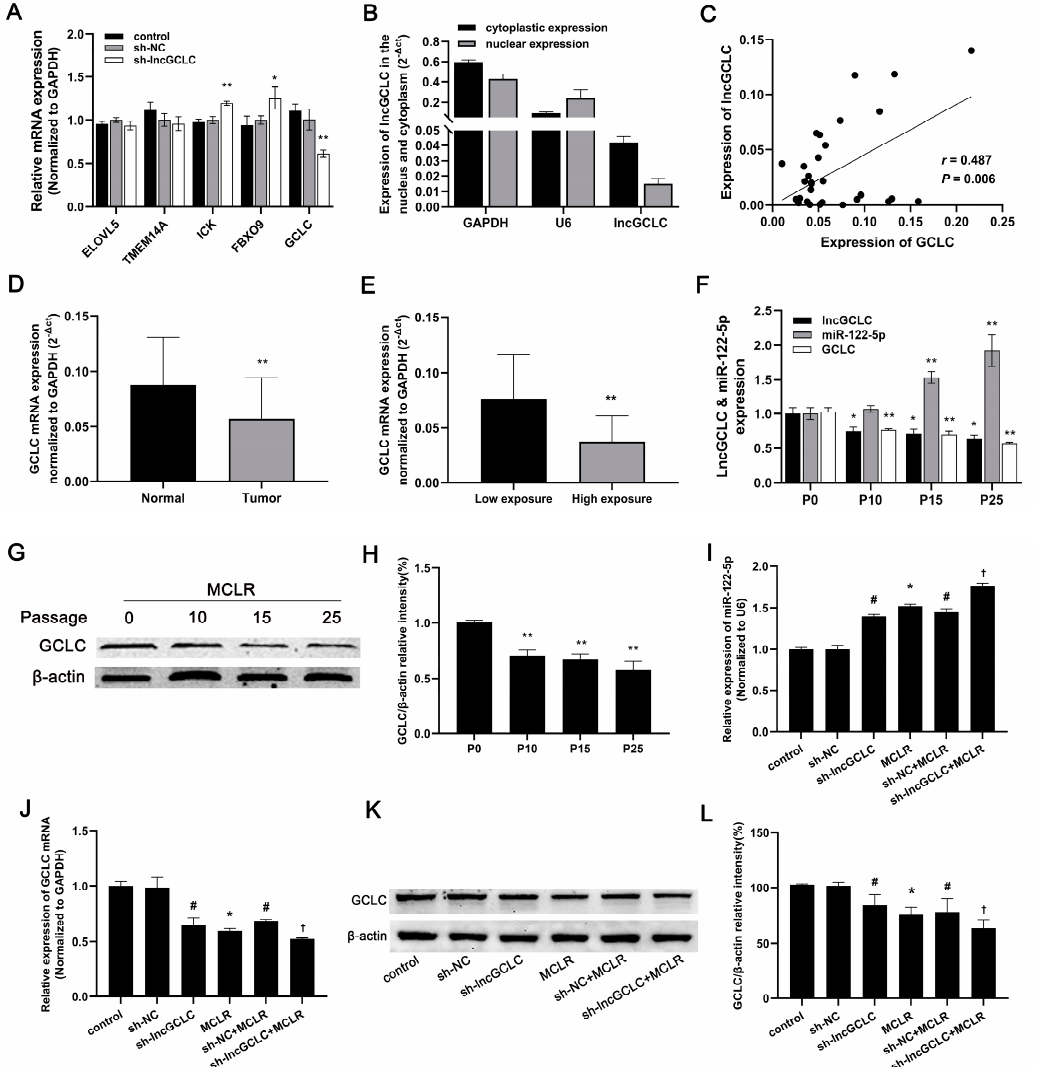
Figure 5. Verification of the interrelationships among lncGCLC, miR-122-5p, and GCLC. ( A ) The mRNA expression level of neighboring genes which are located nearly 1.5 Mb downstream of lncGCLC in lncGCLC knockdown cells. * p < 0.05 and ** p < 0.01 compared with vector control cells. ( B ) The expression level of lncGCLC in the nuclear and cytoplasmic fractions of WRL68 cells. ( C ) The correlation between the lncGCLC expression and the GCLC expression in HCC tissues (n = 30). Correlation coefficient ( r ) and P value were calculated by Pearson correlation analysis. ( D ) Comparison of GCLC expression in tumor tissue and adjacent normal tissue from HCC patients with MC exposure (n = 30), ** p < 0.01. ( E ) GCLC expression in HCC patients with high MC exposure (serum MCs ≥ 0.14 μ g/L, n =17) was lower than in those with low MC exposure (serum MCs < 0.14 μ g/L, n = 13), ** p < 0.01. ( F ) After exposure to 10 μ g/L of MCLR for 0, 10, 15, and 25 passages, expression of lncGCLC, miR-122-5p and GCLC mRNA was detected in WRL68 cells. * p < 0.05 and ** p < 0.01 compared with passage-matched control cells. ( G , H ) Expression of GCLC protein in P0, P10, P15 and P25 MCLR-induced malignantly transformed WRL68 cells. ** p < 0.01 compared with passage-matched control cells. ( I ) Changes of miR-122-5p in both vector- and sh-lncGCLC-transfected WRL68 cells treated with 0 or 10 μ g/L of MCLR for 25 passages. ( J – L ) Changes of GCLC mRNA ( J ) and protein ( K , L ) expression in both vector- and sh-lncGCLC-transfected WRL68 cells treated with or without 10 μ g/L of MCLR for 25 passages. Data are presented as the means ± SD of three independent experiments in each group. * p < 0.05 compared with the control group; # p < 0.05 compared with the sh-NC group; † p < 0.05 compared with the sh-NC + MCLR group.